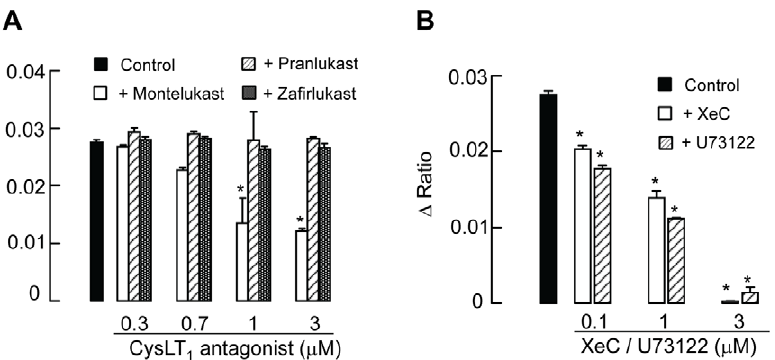
Figure 4. Effect of CysLT 1 receptor antagonists, montelukast, pranlukast, and zafirlukast on UDP-evoked [Ca 2 + ] i responses. (A) Cells were stimulated with UDP in the absence (control) or presence of different concentrations of CysLT 1 receptor antagonists applied 10 min prior to the addition of UDP (100 m M). (B) The UDP-evoked [Ca 2 + ] i responses were inhibited by different concentrations of an IP 3 receptor antagonist, XeC, or a PLC inhibitor, U73122. Each column represents the mean 6 S.E. ( n =4–6). (*, p , 0.05, one-way ANOVA with Bonferroni post-hoc test compared with control).